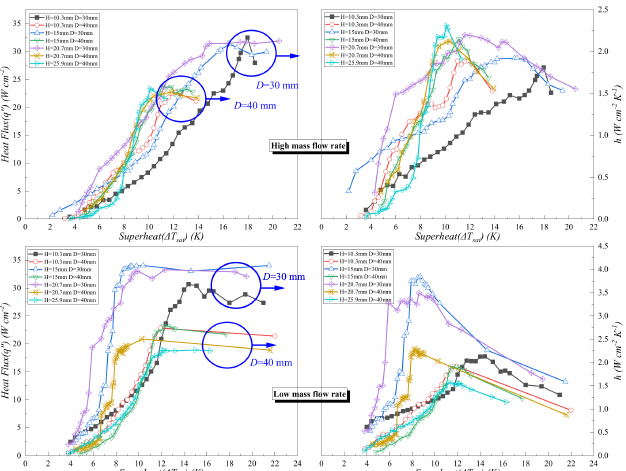
lower than 35 W · cm − 2 and 2.5 W · cm − 2 · K − 1 .